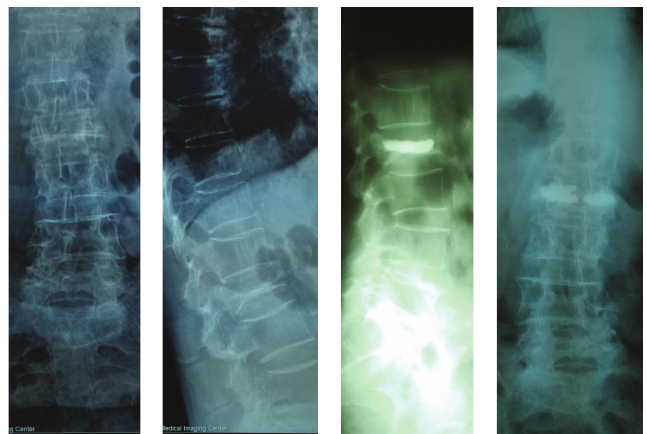
Figure 4: An 80-year-old woman with OCF of L2 (vertebra plana). She was treated with bilateral transpedicular VP.